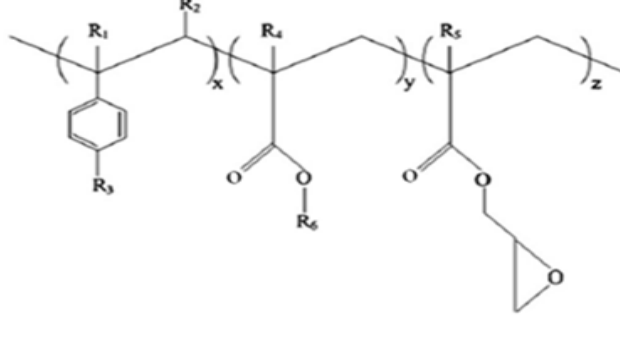
Figure 2. General structure of reactive oligomers (chain